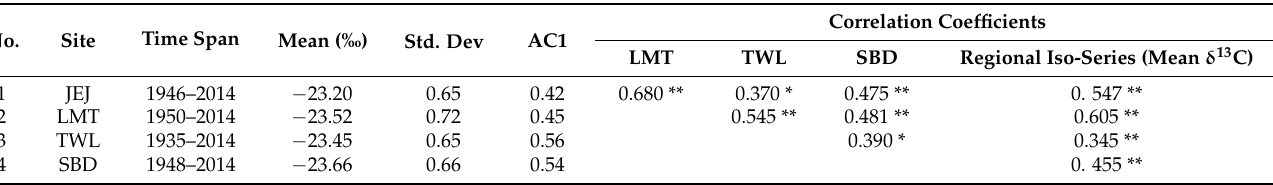
Table 3. Site information and Pearson correlation coefficients for tree-ring ∆ 13 C chronologies among sites and tree-ring δ 13 C series within sites.